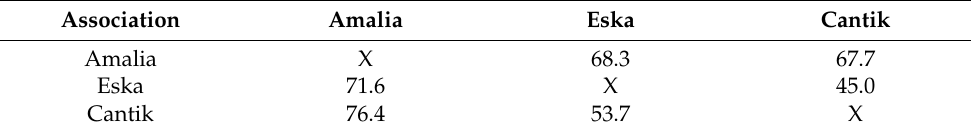
Table 5. Percent of scans juveniles spent in association with each other (within 10–50+ m).